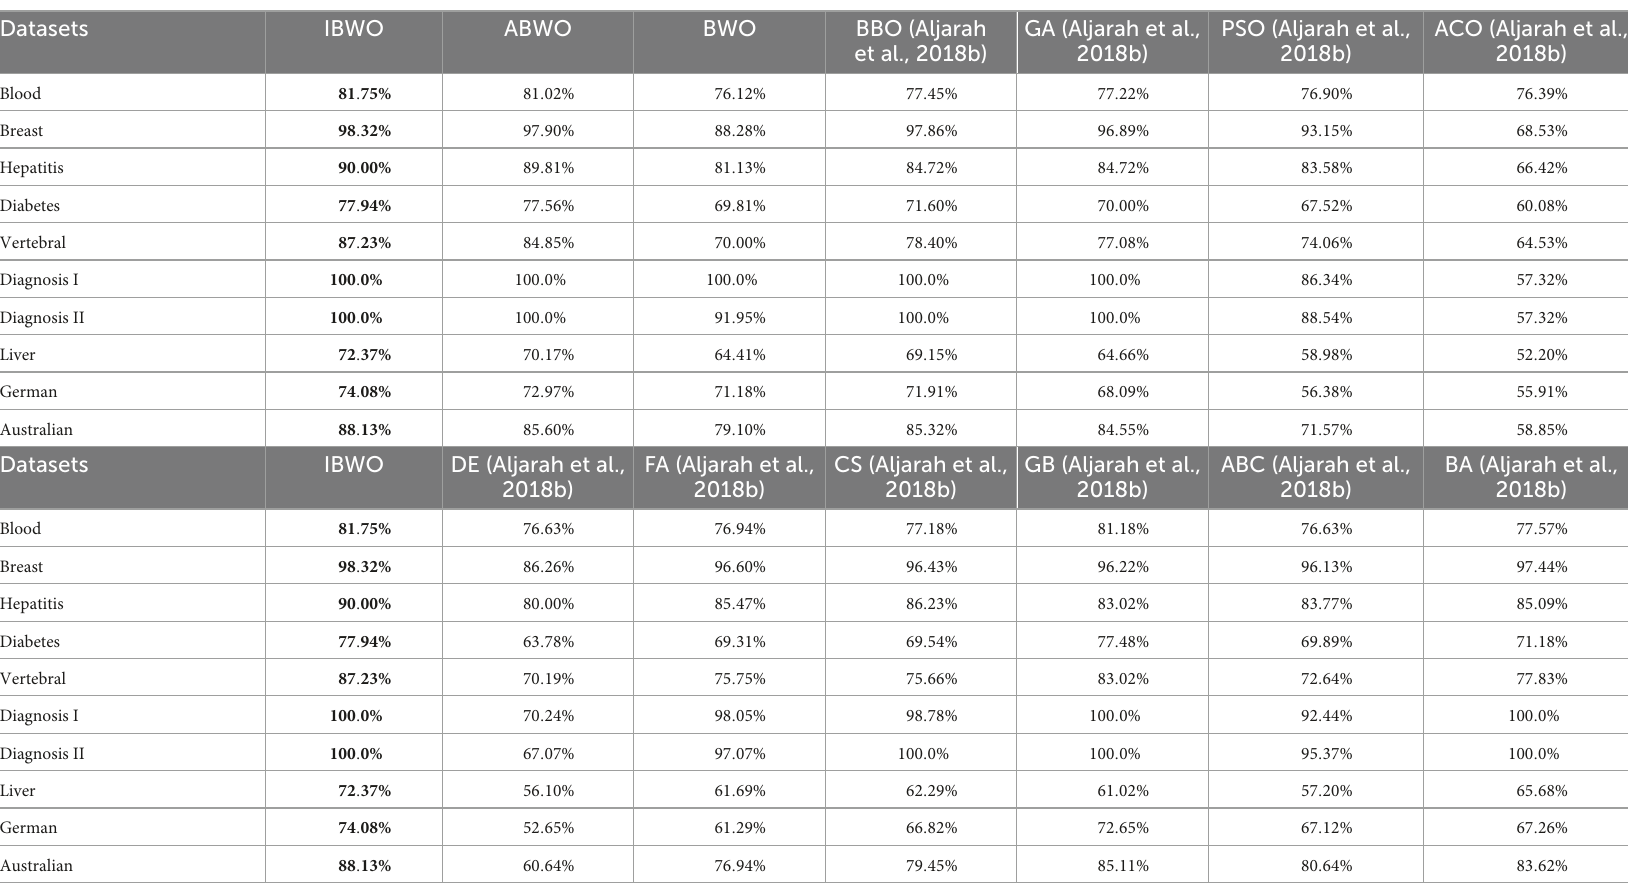
TABLE 2 Average classification rate (in %) of 13 algorithms on 10 datasets.